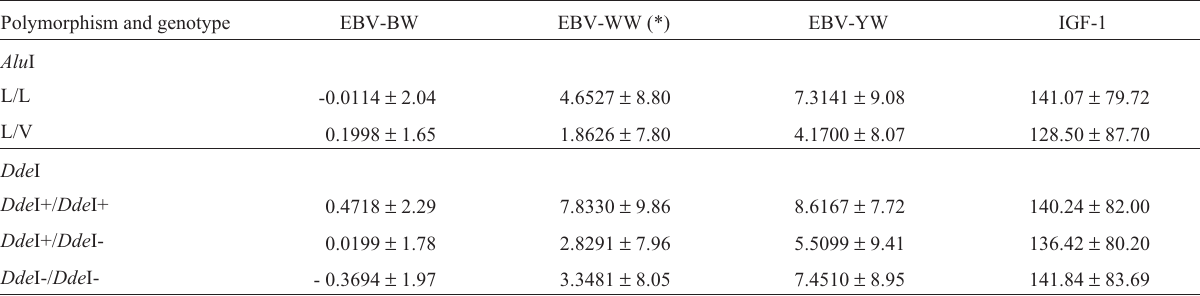
Table 4 - Mean estimated breeding values (EBV) for birth weight (BW), weaning weight (WW), yearling weight (YW) and mean plasma insulin-like growthfactor-1(IGF-1)concentrationfordifferentgenotypesofthegrowthhormone1gene( GH1 )polymorphisms Alu Iand Dde IofCanchimcalves. Polymorphism and genotype